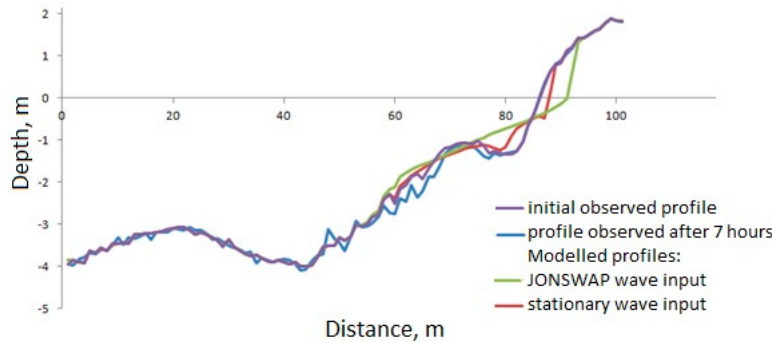
Figure 3. Results of the XBeach verification for the Shkorpilovtsy study site, for cases of 7 h wave action (significant wave height Hs = 0.9 m, and spectral peak period Tp = 7